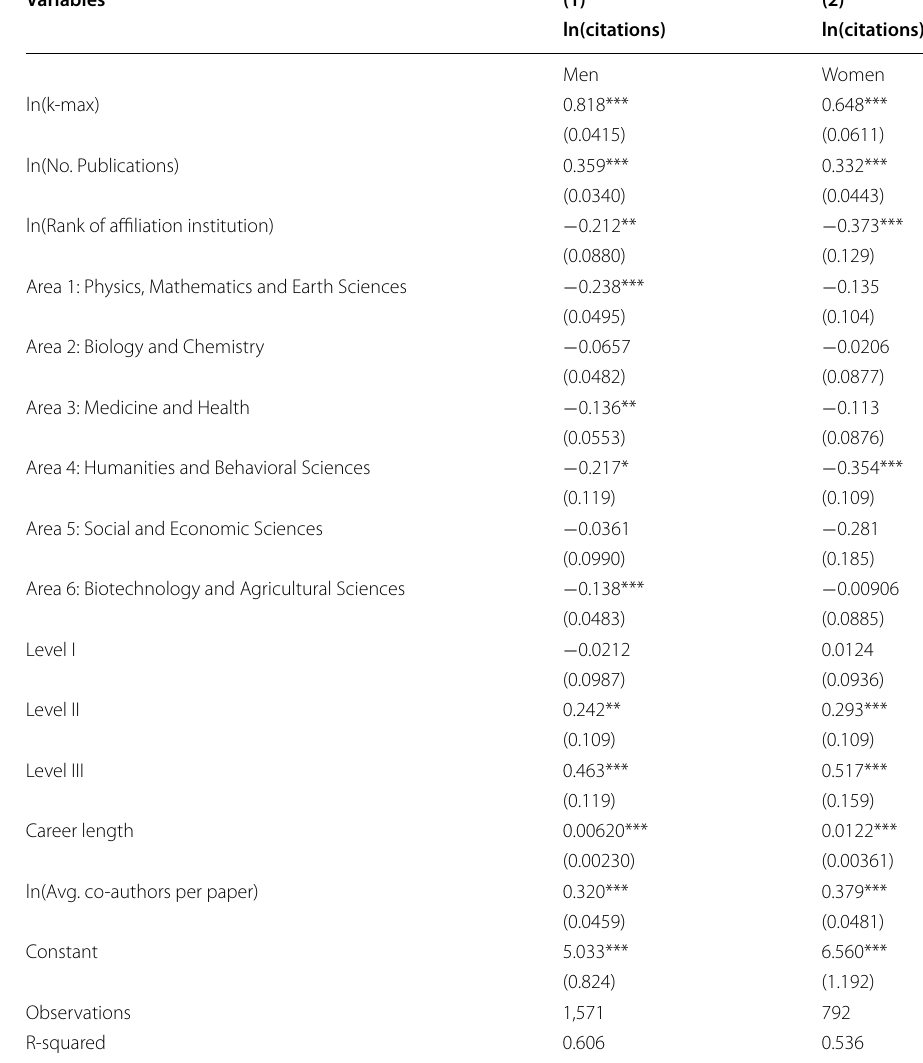
Table 13 Effect of individual and network characteristics on ln(citations) of an author by